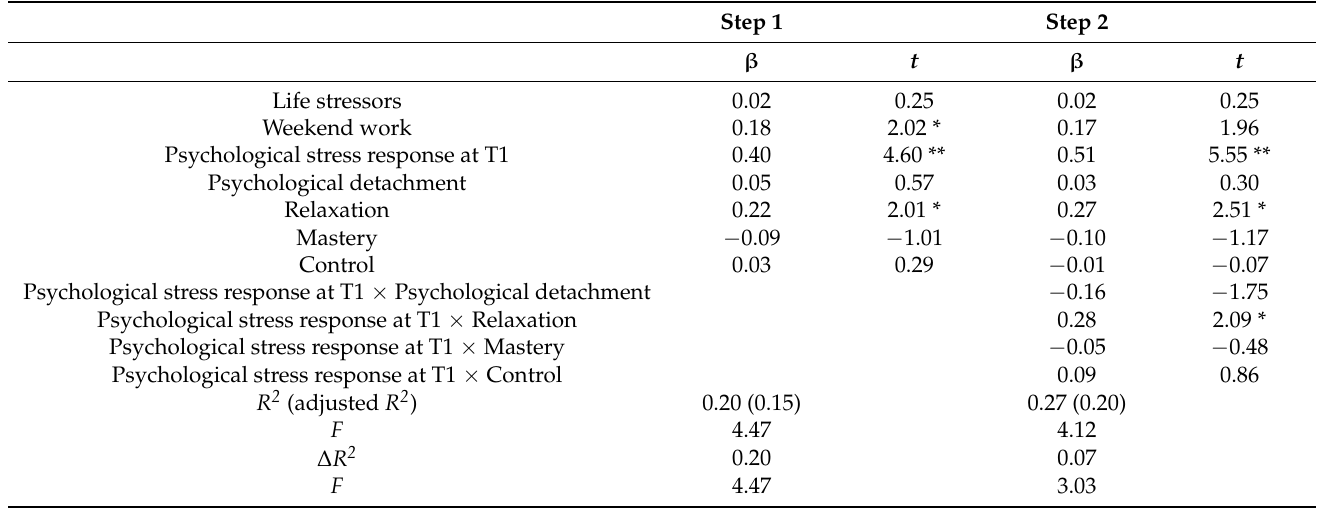
Table 3. Results of the hierarchal regression analysis of predictors of the reduction of psychological stress response from Time 1 to Time 2 ( n =